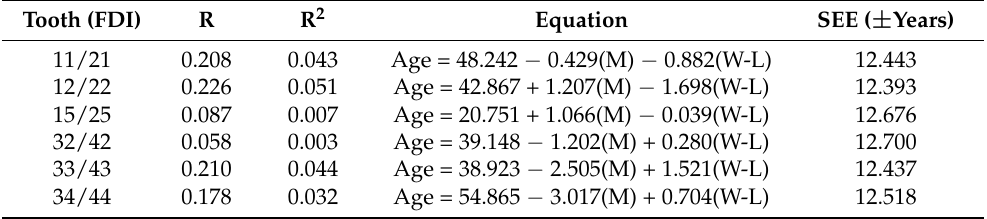
Table 3. Multiple regression models for estimation of chronological age (in years) from individual maxillary and mandibular teeth a .